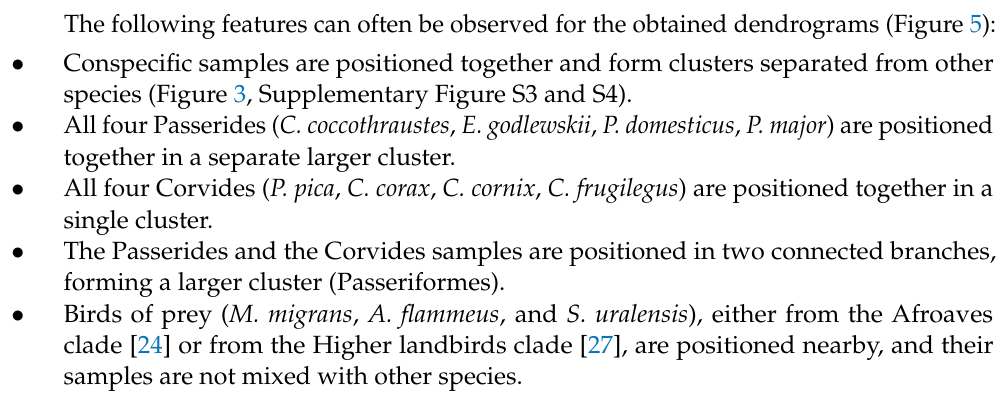
Figure 5. Comparison of metabolomics-based and “classical” dendrograms. Three HCA dendrograms (AEW, PSS and NSS) and two “classical” dendrograms (the phylogenomic-based tree from Jarvis ED et al. [24] and the phylotranscriptomic-based tree from Kuhl H et al. [27]) were analyzed. The dashed green lilac arrow indicates the absence of Columbea-like clade in HCA dendrograms; green and dark violet arrows indicate the significant mispositioning of C. livia and F. atra , correspondingly; dashed magenta, mint and light green arrows indicate the slight mispositioning of C. frugilegus, P. pica and P. major, correspondingly; dashed aquamarine arrows indicate the mixing of the Corvidae samples in the PSS dendrogram; the orange arrow indicates the absence of the the Afroaves/Higher landbirds-like clade in the NSS dendrogram.